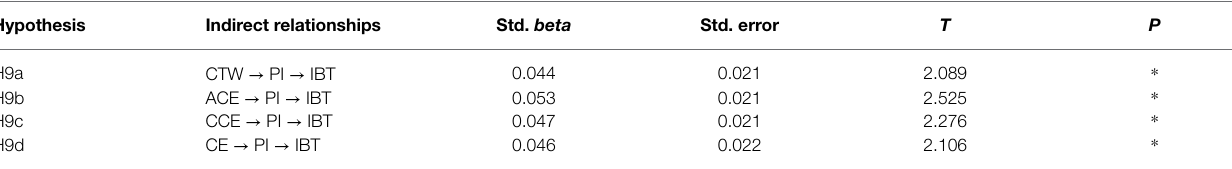
TABLE 5 | Hypotheses testing mediation